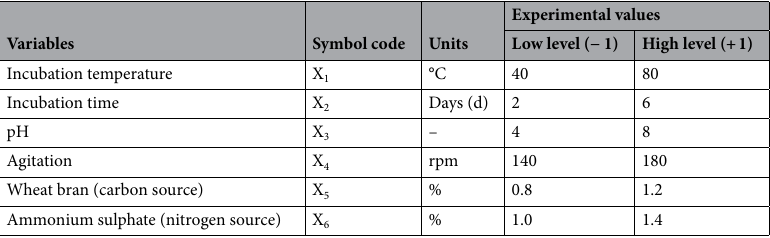
Table 1. Experimental variables and levels used in the PBD for optimal xylanase production by the Trichoderma harzianum